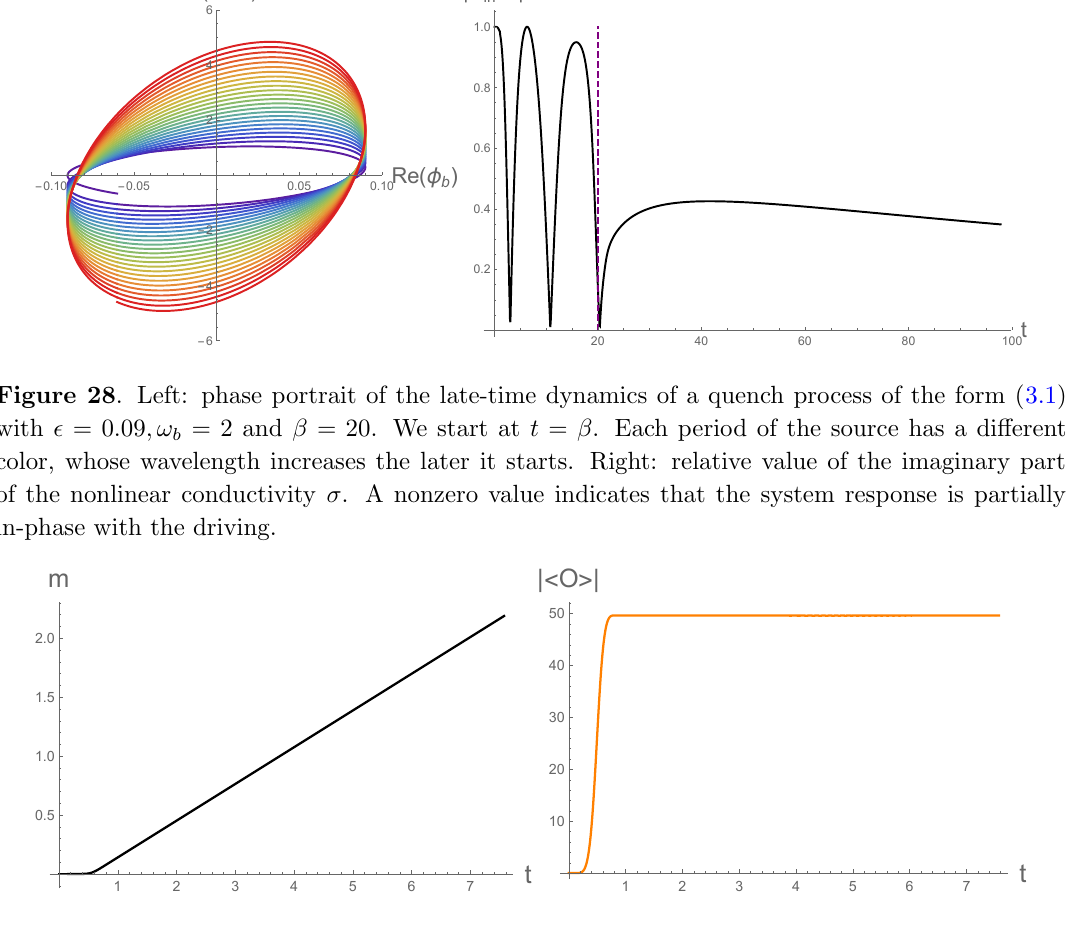
Figure 29 . Time evolution of the energy density (left) and vev modulus (right) for a quench process of the form (3.1) with (cid:15) = 10 (cid:0) 4 ; ! b = 20 (cid:25) and (cid:12) =